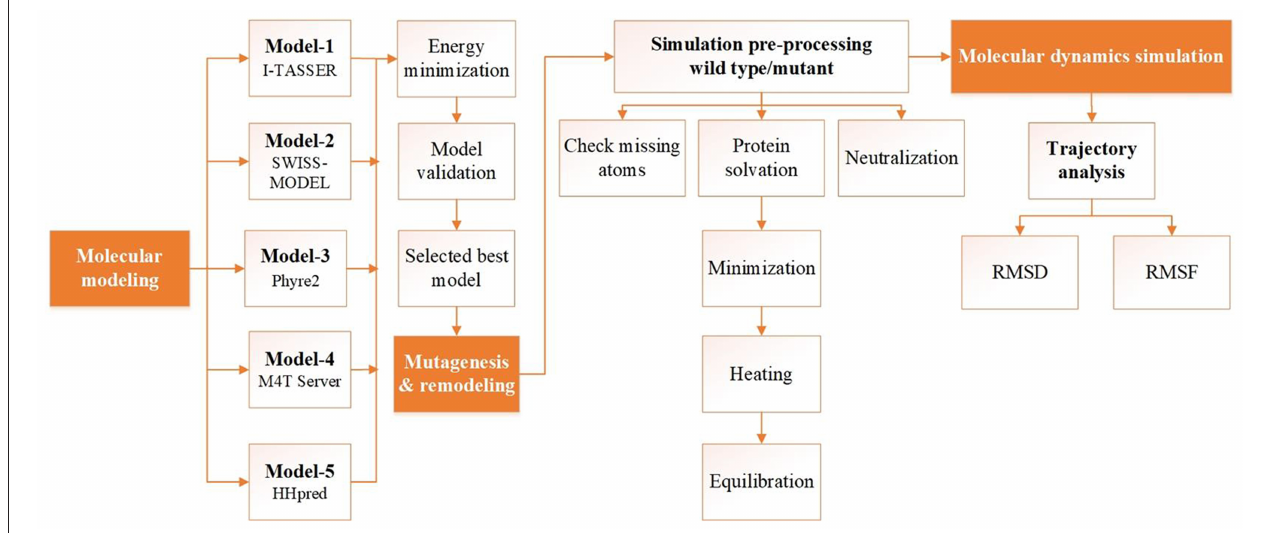
FIGURE 1 | Flowchart of the structure prediction and analysis pipeline. Schematic illustrating the structure prediction and analysis pipeline consisting of model building, validation, and molecular dynamics simulation analysis. Each step corresponding to the protocol is described in the main